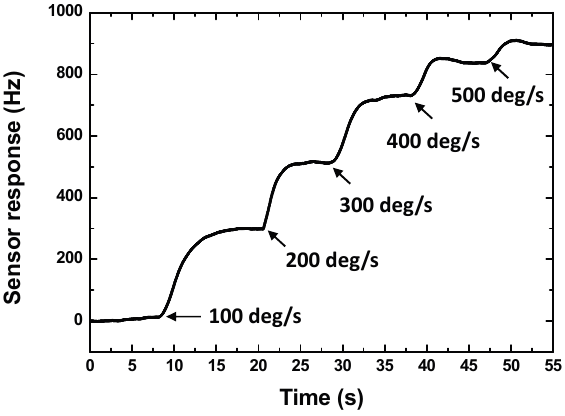
Figure 7. The continuous response of the stimulate 95 MHz sensor on X-112°Y LiTaO 3 with 300 nm thick Cu dot array.